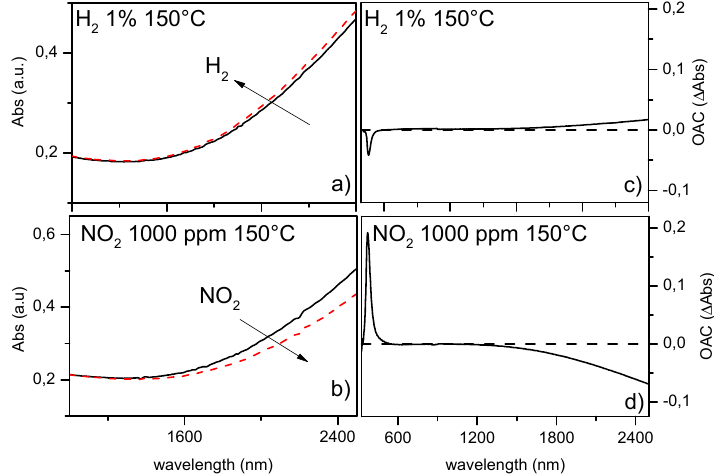
Figure 2. Optical absorption spectra for GZO10 sample when exposed to air (black solid lines) and ( a ) H 2 1% vol or ( b ) NO 2 1000 ppm (red dashed lines) at 150 °C OT. ( c , d ) show optical absorbance change (OAC = Abs gas − Abs air ) for GZO10 at 150 °C when exposed to H 2 and NO 2 ,